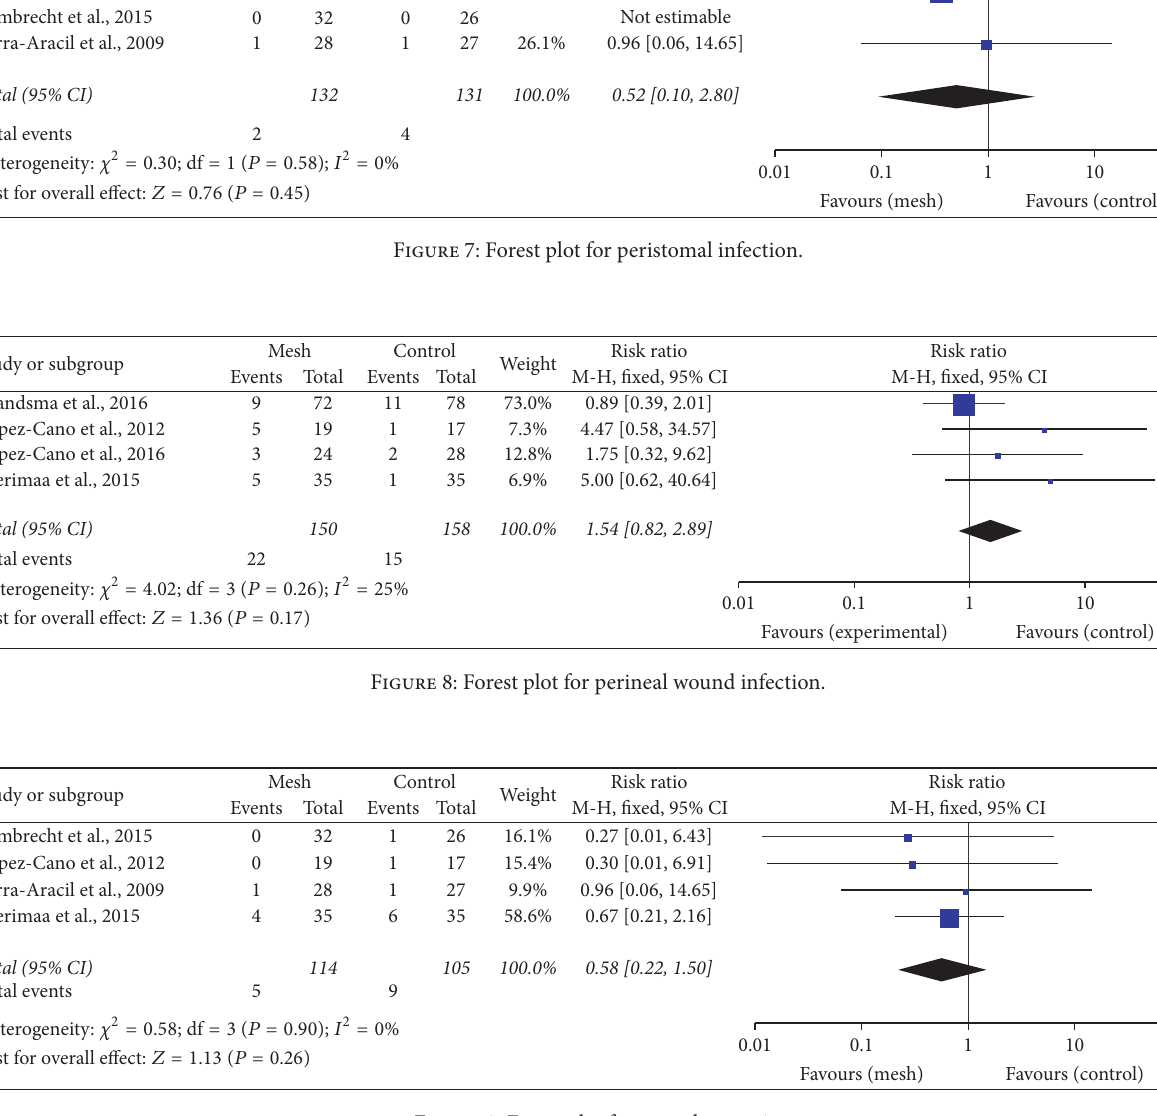
Figure 9: Forest plot for stomal